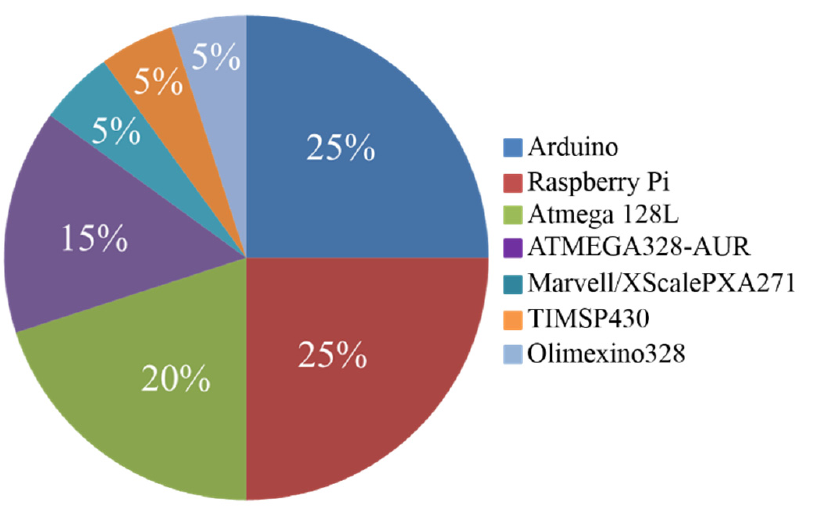
Figure 5. Distribution of research papers based on the types of microcontrollers.